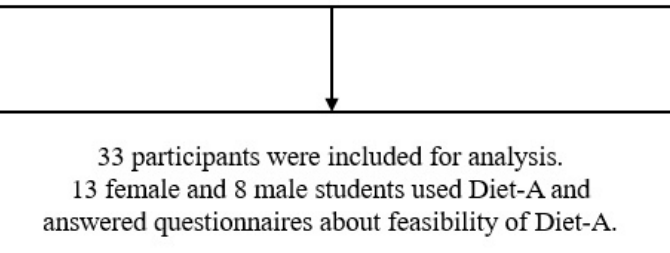
Figure 2. Flowchart of participants.